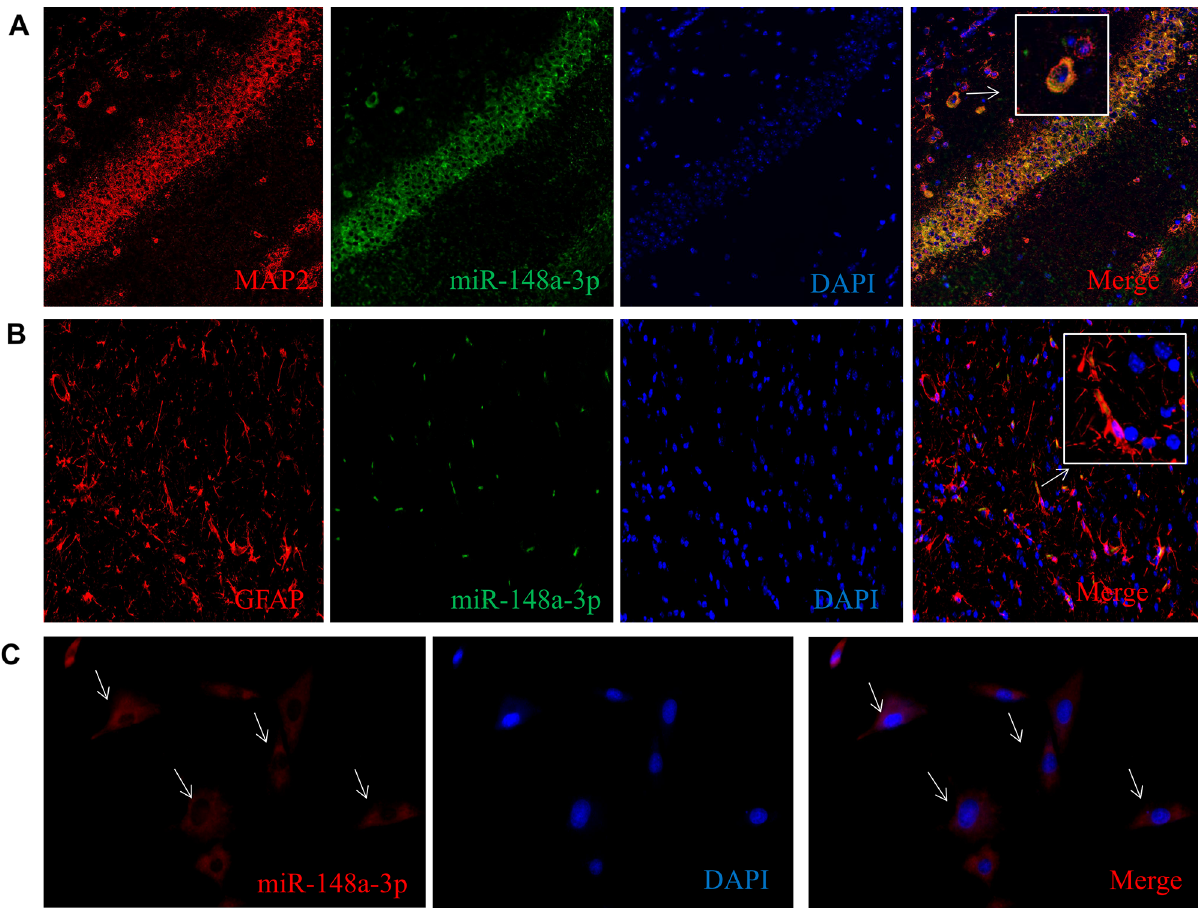
Figure 5. Sub-cellular location of miR-148a-3p in vivo and vitro. ( A – C ) Cellular location of miR-148a-3p in neuronal cells in normal rat hippocampus tissue. ( D – F ) Cellular location of miR-148a-3p in astrocyte cells in normal rat hippocampus tissue. ( G – I ) MiR-148a-3p was localized in the cytoplasm of H19-7 hippocampal neuronal